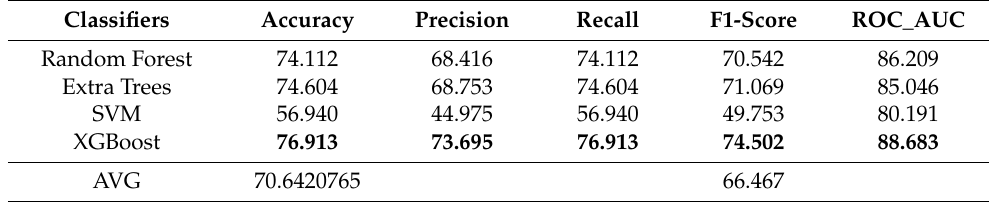
Table 1. DNA Raw Experimental Results.